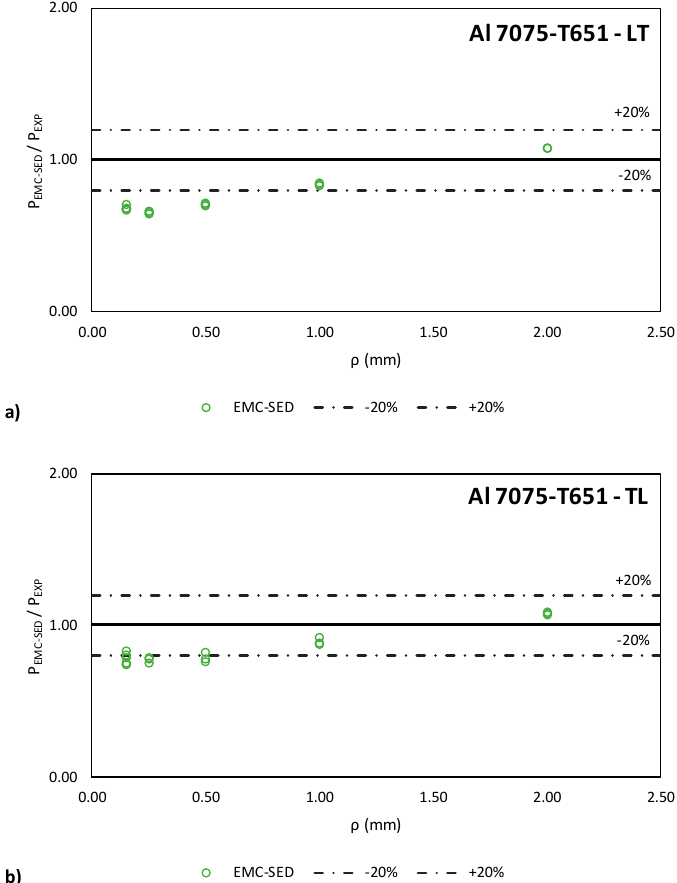
Figure 9. Comparison between fracture load predictions (EMC - SED criterion) and experimental fracture loads; ( a ) TL specimens; ( b ) LT specimens.